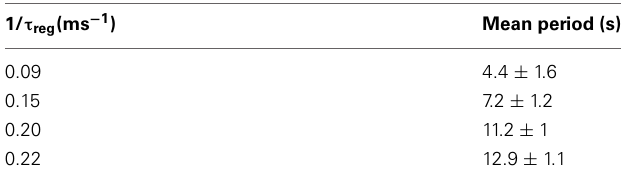
Table 2 | Comparison of burst characteristics in the two digital implementations and the biological system.